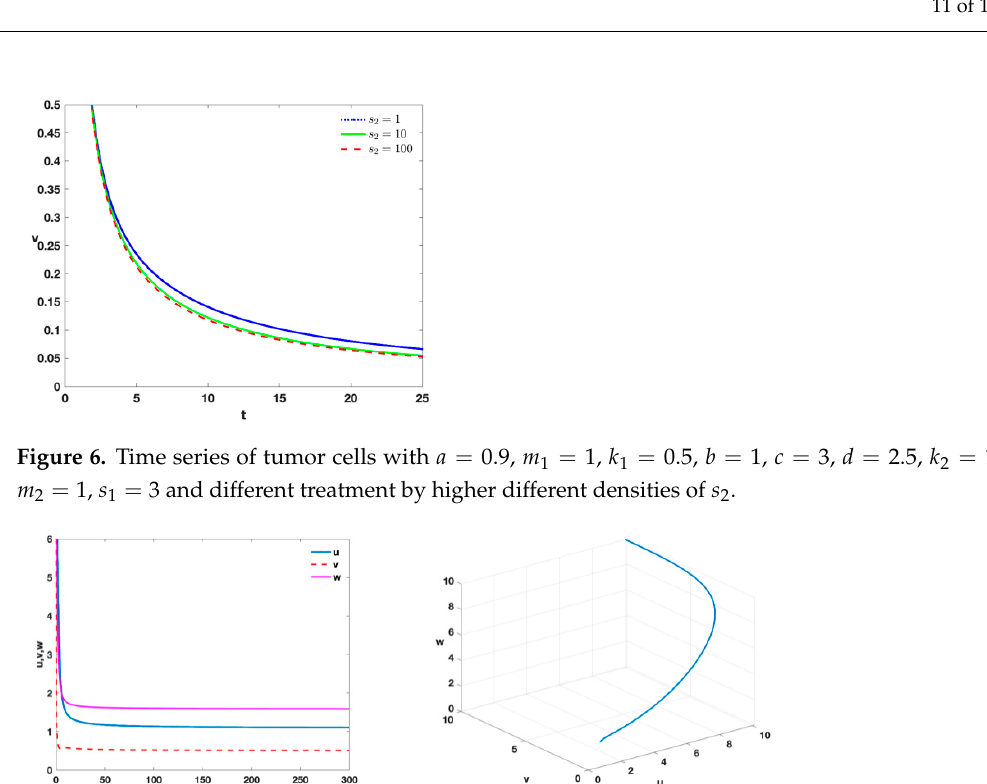
Figure 5. Time series of tumor cells with and different treatment by the different densities of